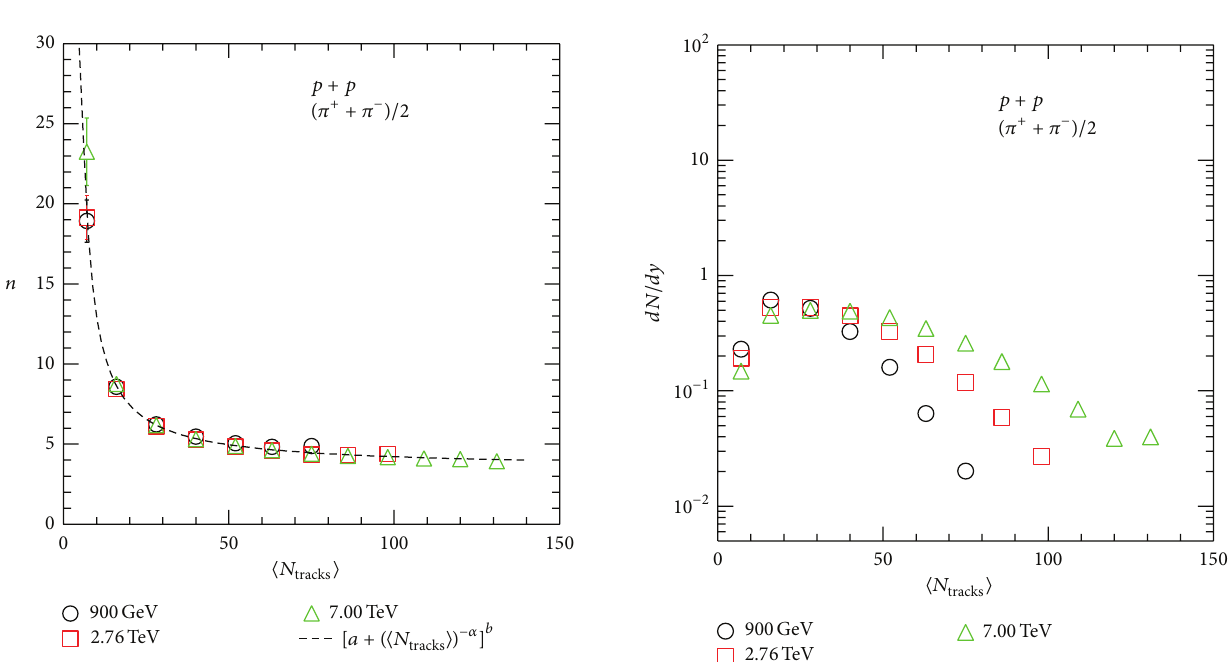
Figure 10: The variation of the integrated yield 𝑑𝑁/𝑑𝑦 for charged ⟩ . The variation is shown for 900 GeV pions as a function of ⟨𝑁 tracks by black circles, 2.76 TeV by red squares, and 7.00 TeV by green ⟩) −𝛼 ) 𝑏 . tracks